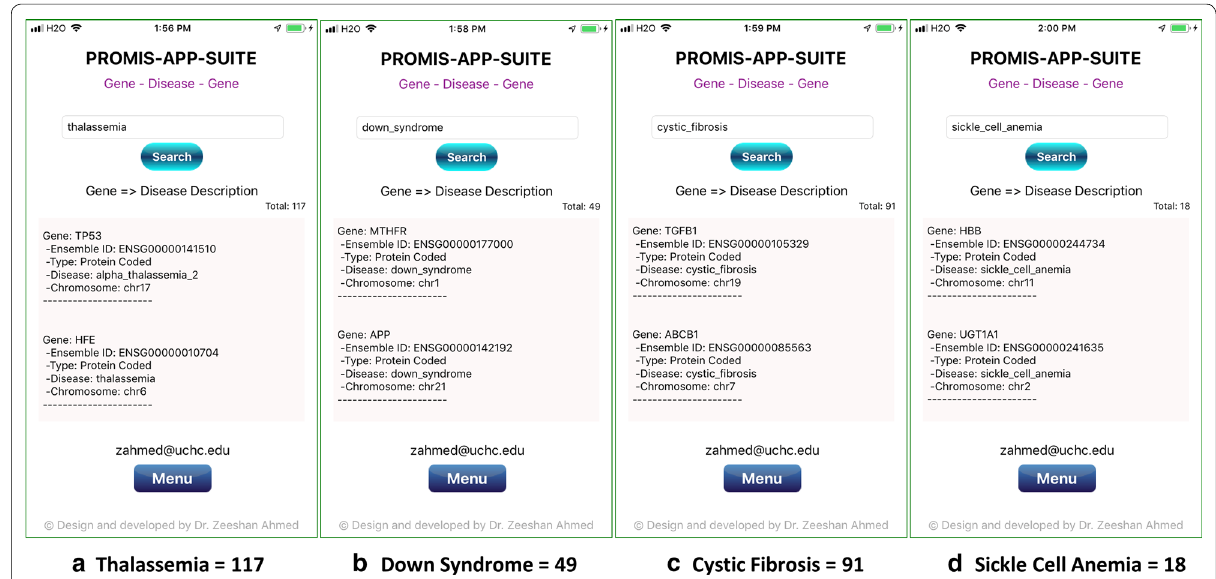
Fig. 5 PAS-Gen screenshots examples of gene results (top two shown) for searches of common genetic diseases: a 117 results for Thalassemia, b 49 results for Down syndrome, c 91 results for Cystic Fibrosis, and d 18 results for Sickle Cell Anemia. Detailed results are attached in Additional file 1